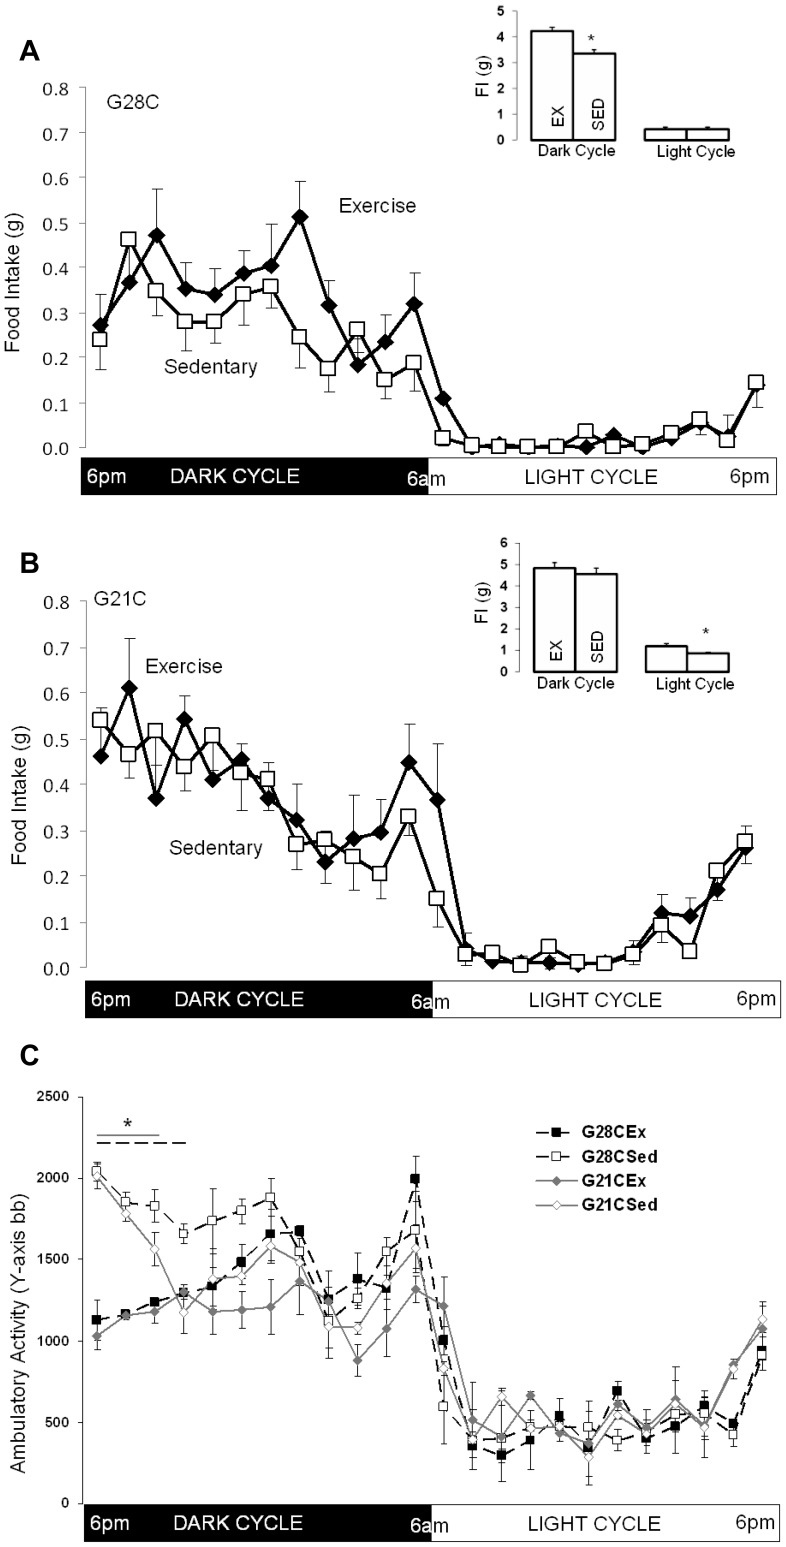
Effect of exercise cessation on food intake (FI) and ambulatory activity (AA) in G28C and G21C groups.A. G28C group (n = 8) housed at 28°C. Mean hourly FI (g) during the entire photoperiod with Exercise and after running wheels were locked (Sedentary). Insert: Cumulative mean dark cycle and light cycle FI in G28C mice during the Exercise period (EX) and after running wheels were locked (SED). B. G21C group (n = 8) housed at 21°C. Mean hourly FI (g) during the entire photoperiod with Exercise and after running wheels were locked (Sedentary). Insert: Cumulative mean dark cycle and light cycle FI in G21C mice during the Exercise period (EX) and after running wheels were locked (SED). C. Mean hourly ambulatory activity (Y-axis beam breaks) in both G28C and G21C groups (n = 8/group) during exercise period (Ex) and following exercise cessation (Sed). All data shown as means ± SEM for 3(EX) or 4(SED) consecutive days; for A and B * signifies p<0.05 by pair-wise t-test within groups, for C * signifies p<0.05 by one-way ANOVA for all hours indicated by the two lines (solid gray line G21C, dashed black line G28C).